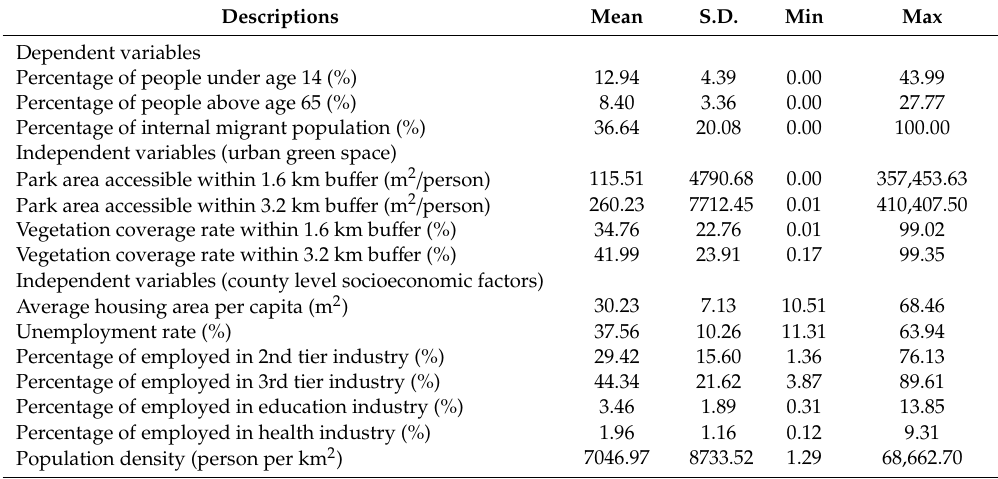
Table 1. Descriptive statistics of township-level social groups, urban green space distributions, and county-level socioeconomic